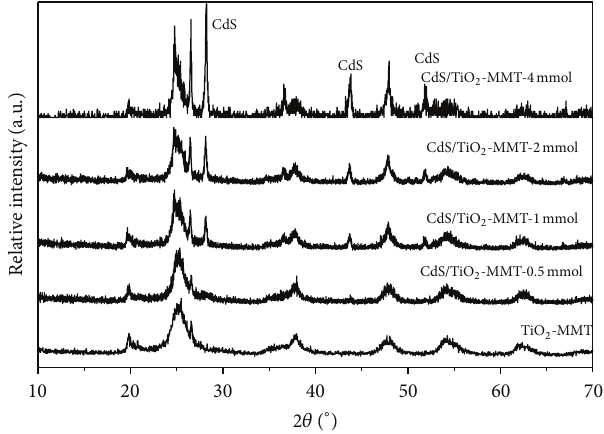
Figure1:LargeangleXRDspectrumsofCdS/TiO 2 -MMT(10 ∘ –70 ∘ ).